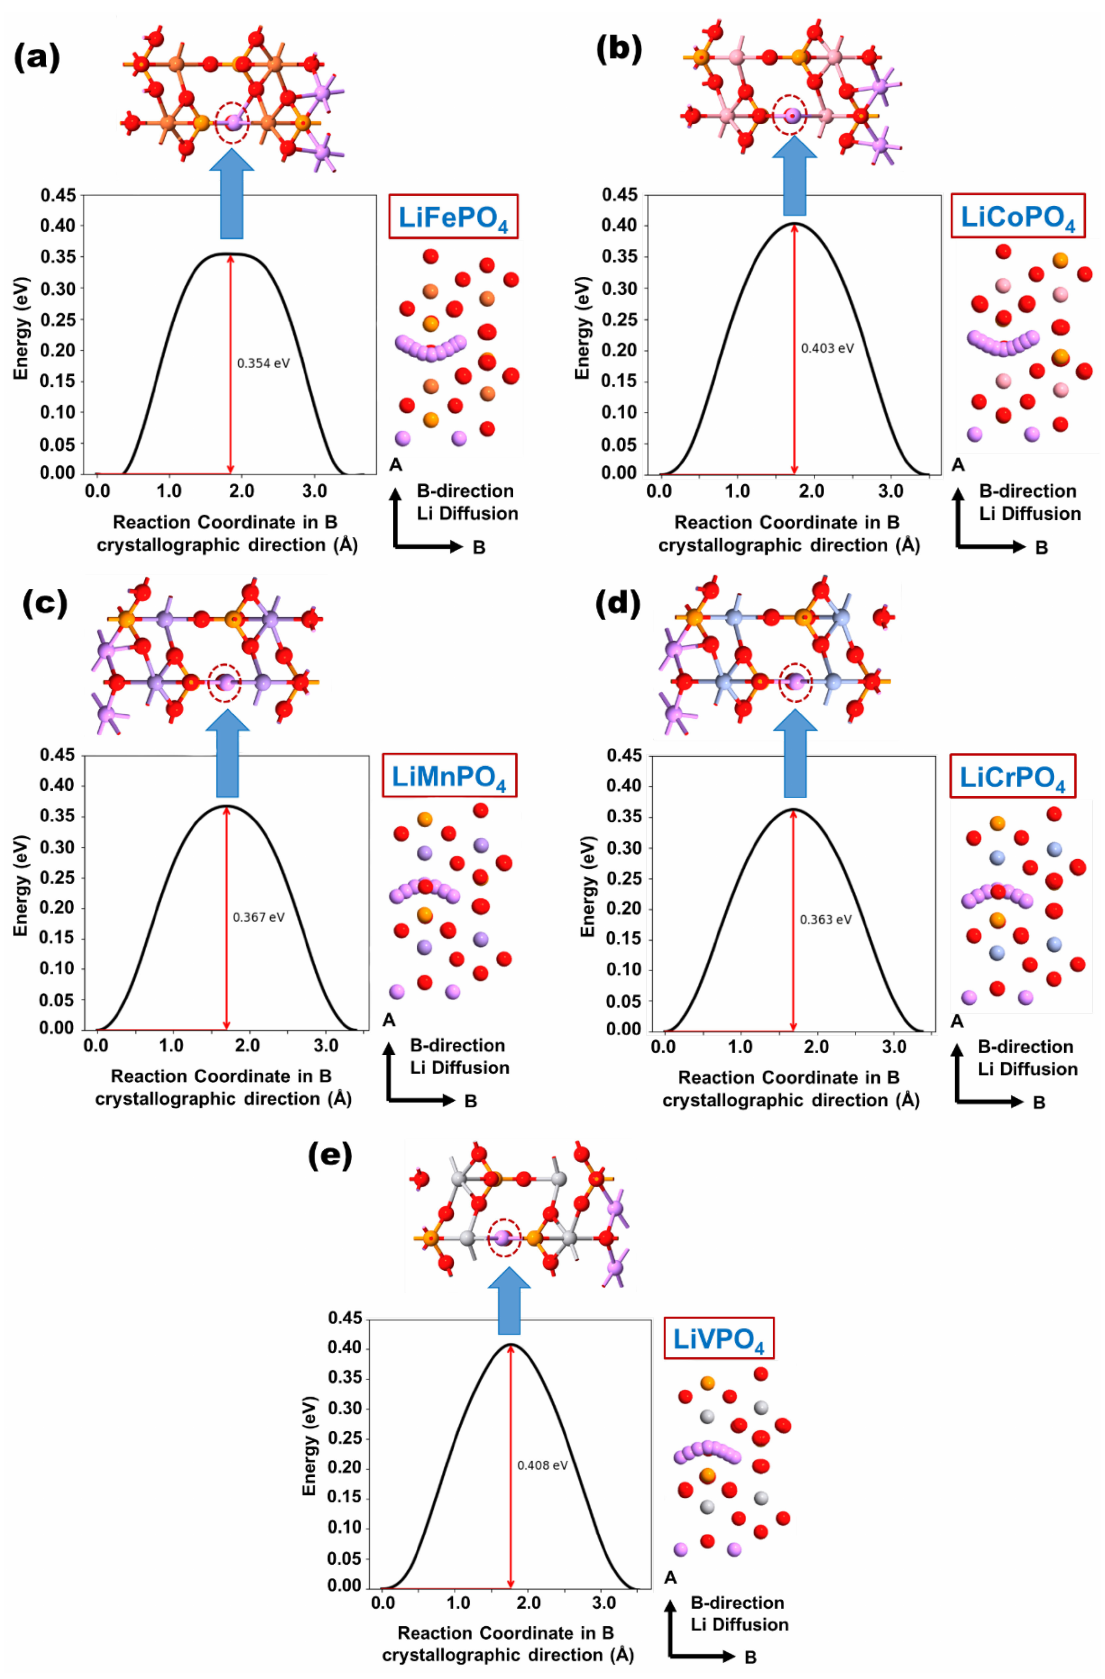
Figure 6. Plots of Li diffusion activation barrier along B-crystallographic axis and corresponding over- lay image of Li diffusion for ( a ) LiFePO 4 , ( b ) LiCoPO 4 , ( c ) LiMnPO 4 , ( d ) LiCrPO 4 , and ( e ) LiVPO 4